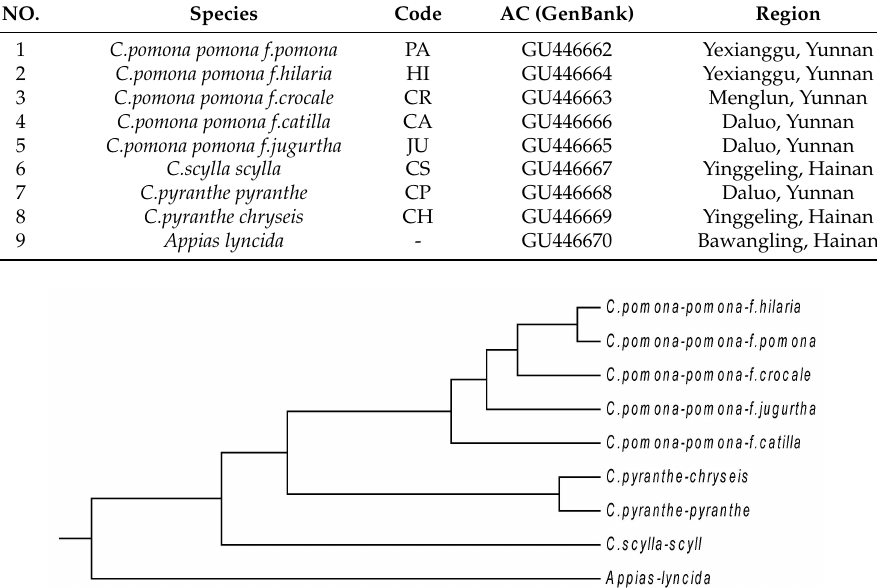
Figure 4. The relationship tree of nine COI (cytochrome oxidase subunit I) gene